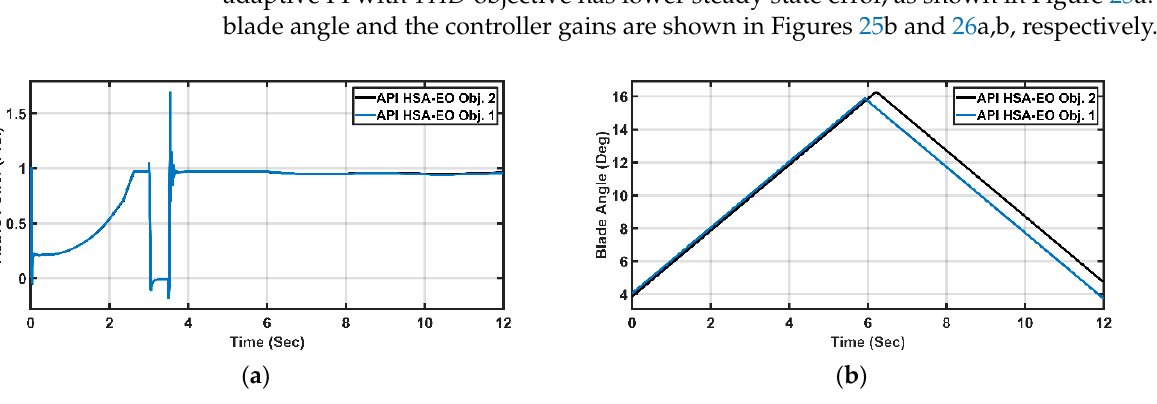
Figure 25. ( a ) Active power responses of faulty first case. ( b ) Blade-angle responses of faulty first case.